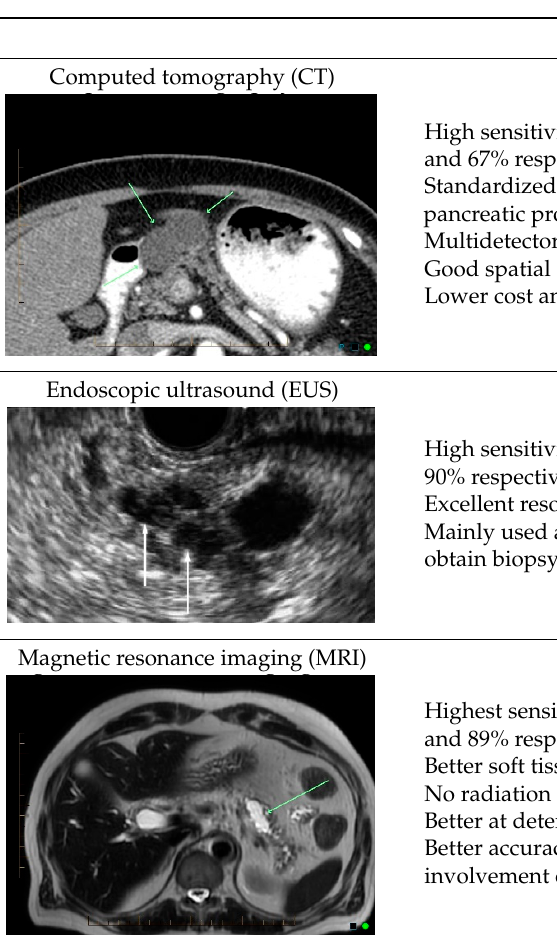
Table 3. Performance of imaging modalities for solid PDAC lesions for early detection.